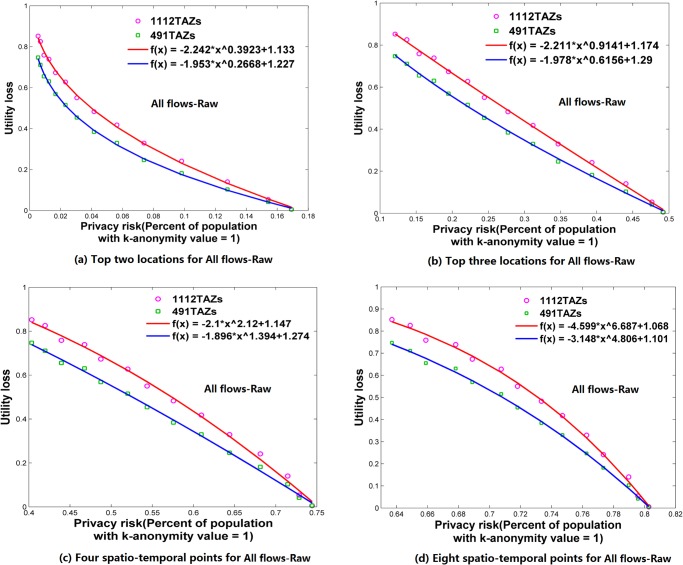
Relationships between privacy risk and data utility using All flows-Raw.(a) Top two locations. (b) Top three locations. (c) Four spatio-temporal points. (d) Eight spatio-temporal points.